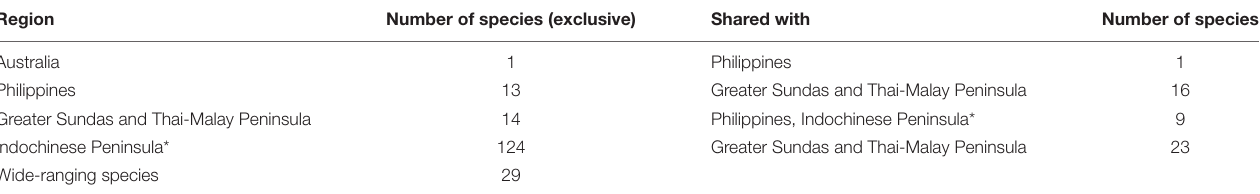
TABLE 3 | Non-breeding distribution of migratory landbirds in different Southeast Asian regions and Australia. Region Number of species (exclusive) Shared